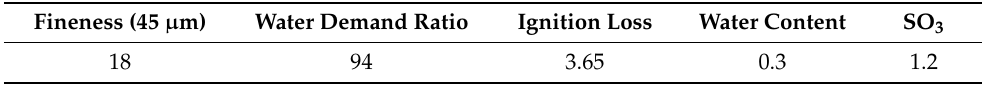
Table 4. Physical properties of fly ash (%).